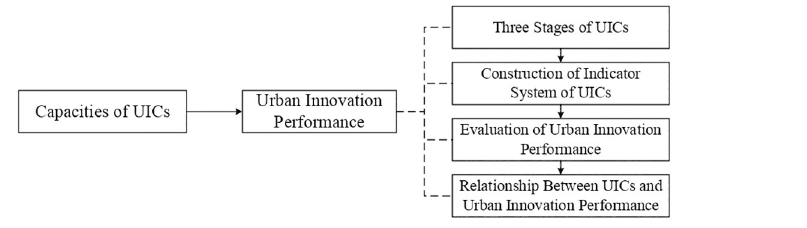
Fig 1. Overall research